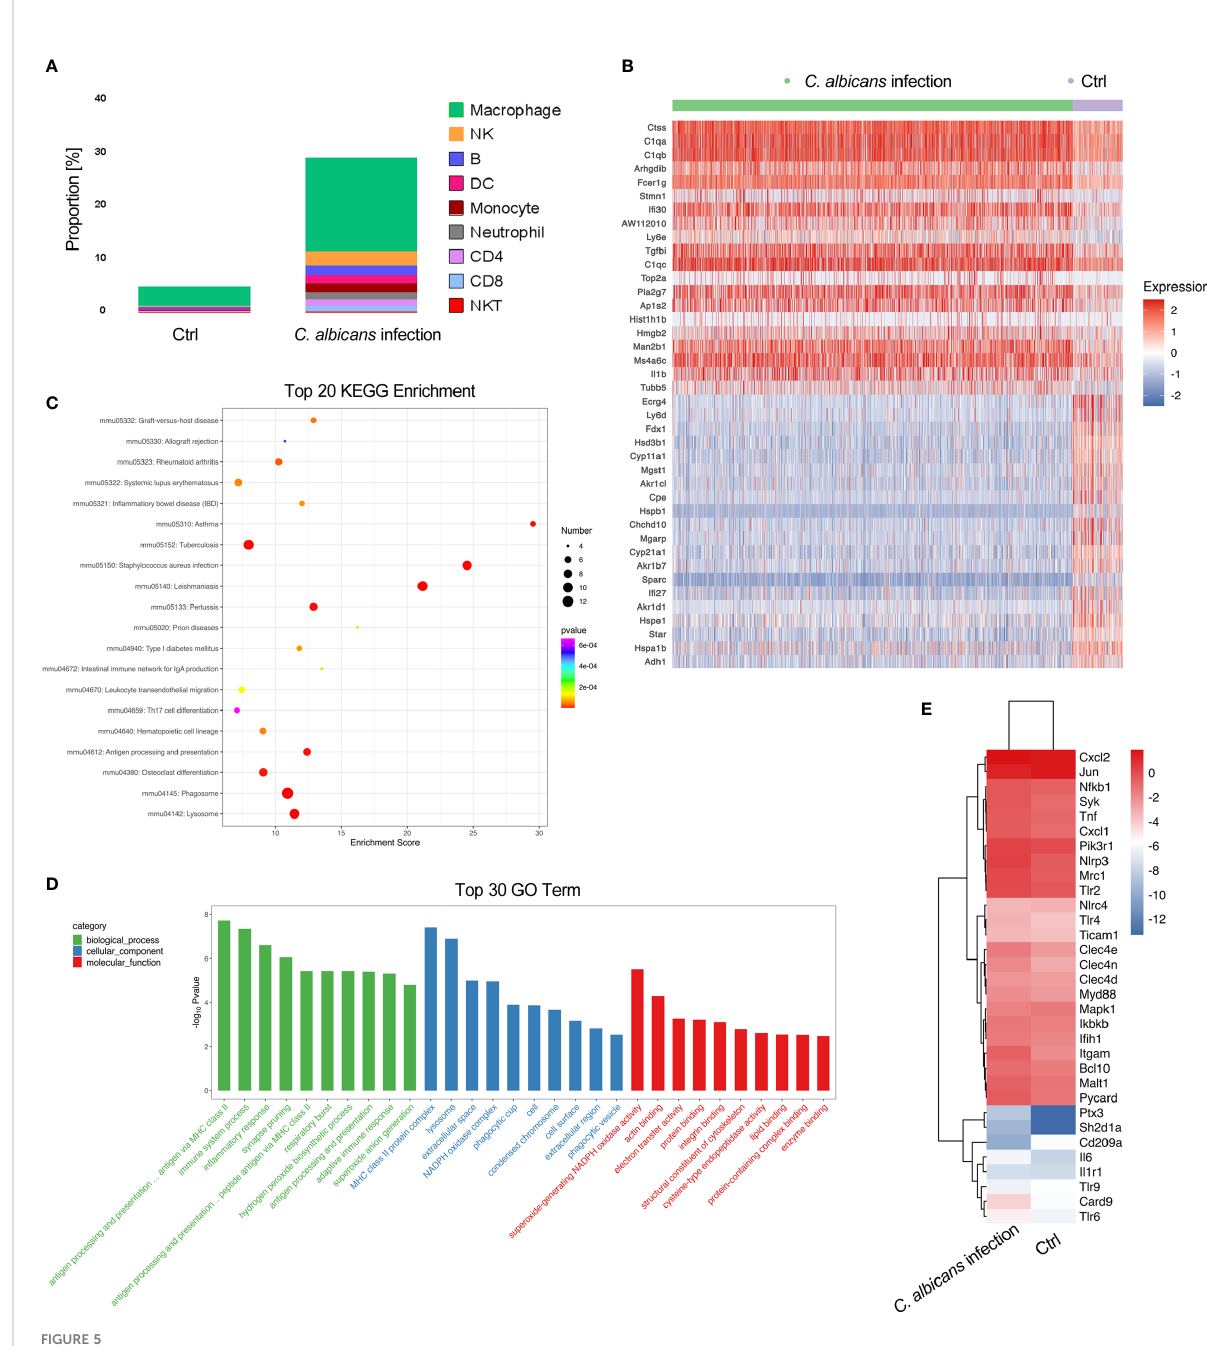
FIGURE 5 In fi ltration of immune cells in the adrenal glands following systemic C. albicans infection and functional analysis of adrenal macrophages. (A) The proportions of immune cells within adrenal glands. (B) Heatmap of the top 20 DEGs in adrenal macrophages between the infected and control groups. (C) KEGG and (D) GO enrichment analyses of the DEGs in adrenal macrophages. (E) Heatmap showing the expressions of PRR genes involved in anti-fungal immunity and the related key signaling molecules in adrenal macrophages of infected mice and uninfected